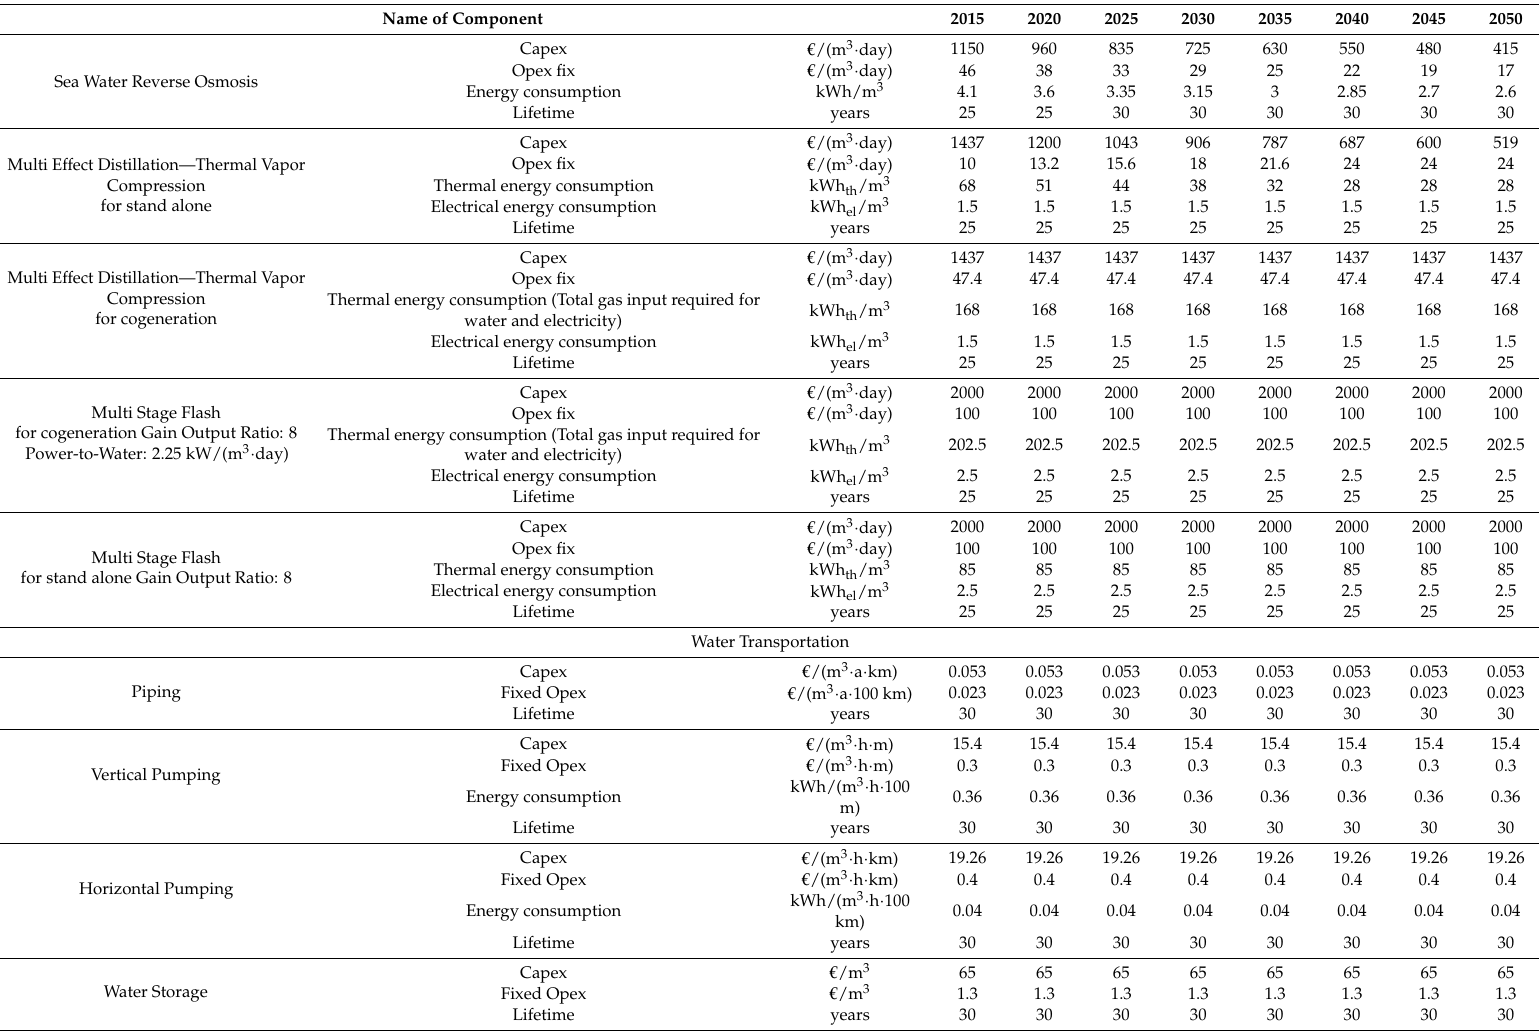
Table A2. Technical and financial parameters of the seawater desalination technologies from 2015–2050